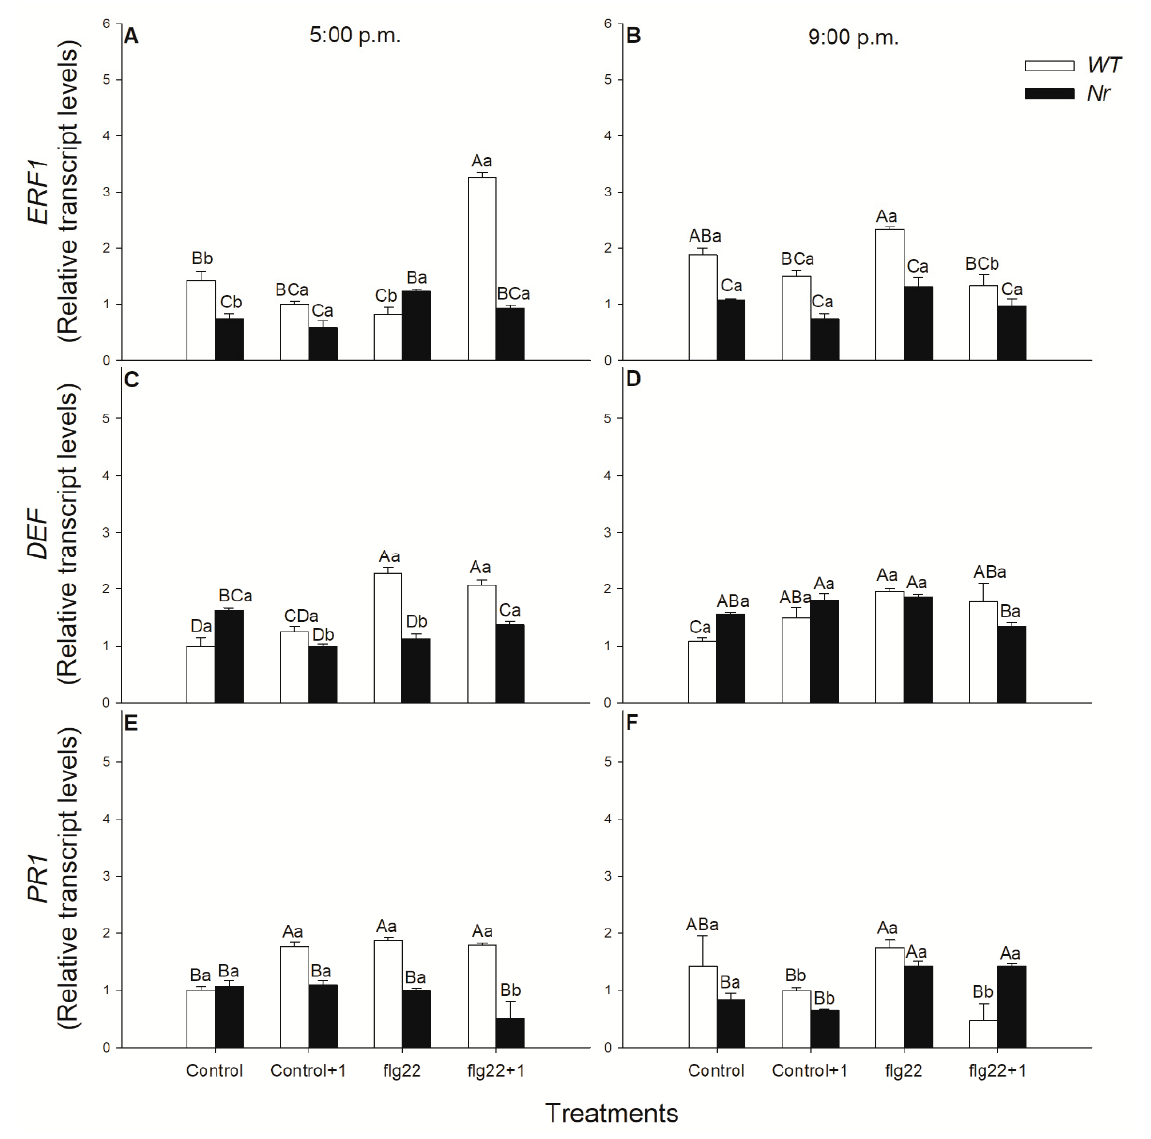
Figure 4. Changes in the relative transcript levels of ERF1 ( A , B ), DEF ( C , D ) and PR1 ( E , F ) in leaves of intact wild type (WT; white columns) and ethylene-insensitive Never ripe ( Nr ; black columns) tomato plants treated foliar using a squirrel-hair brush with 5 µ g mL − 1 of flagellin (flg22) in the late afternoon under light (at 5:00 p.m.) or at night under darkness (at 9:00 p.m.). Measurements were carried out one hour after treatments (at 6:00 p.m. and 10:00 p.m.). Whole leaves from the different leaf levels and genotypes were collected and immediately frozen in liquid nitrogen; then, after RNA extraction, gene expression was analysed using qRT-PCR. Means ± SE, n = 3. Means were analysed by two-way ANOVA; significant differences among the data were analysed by Duncan’s test. Mean values significantly different at p < 0.05 are indicated by different letters, upper case letters indicate the effects of the treatment at the same time of day and lower case letters indicate the effects of daytime under the same treatment. (Control, treatment with sterile distilled water; Control+1, untreated distal leaf level to the control; flg22, treatment with 5 µ g mL − 1 of flagellin dissolved in sterile distilled water; flg22+1, untreated distal leaf level to the flg22-treated